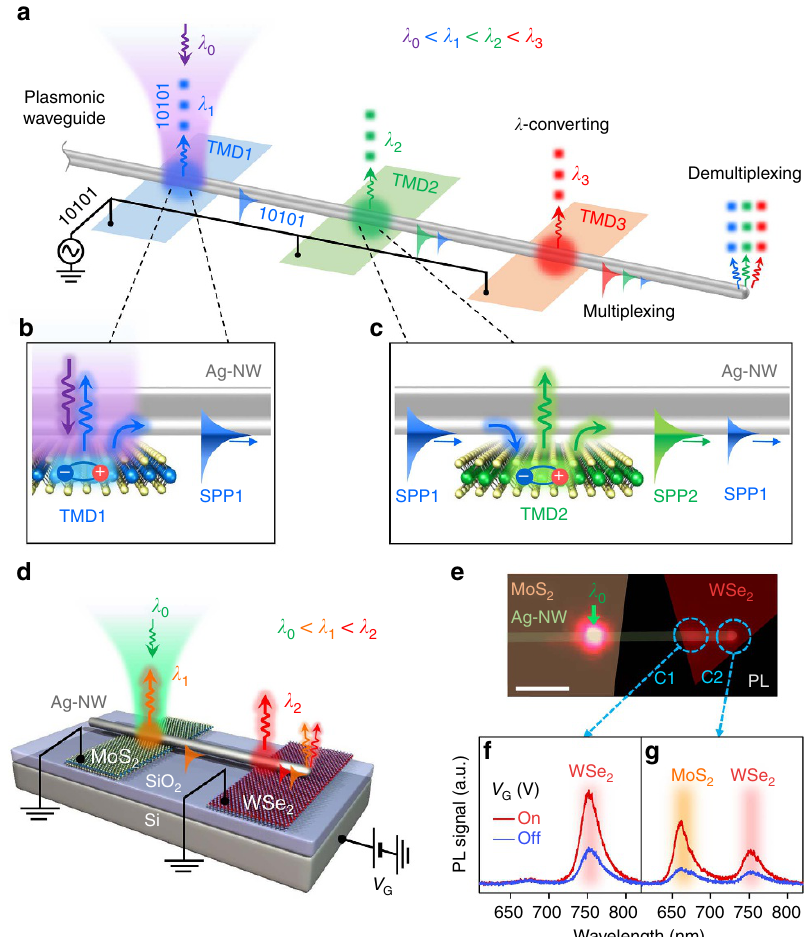
Figure 3 | Exciton multiplexer. ( a ) Laterally arrayed TMDs with different bandgaps bridged via an Ag-NW. The exciton flux of each TMD with the corresponding wavelength ( l ) is switched by electrical doping, ( b ) l 1 excited by the input light is coupled to SPP1 in the NW, ( c ) propagates along the NW and then excites l 2 by partially being absorbed in TMD2 that is coupled to SPP2 in the NW. SPP1 and SPP2 excite l 3 in TMD3 and generate SPP3. The three SPP modes deliver the multiplexed wavelengths with optical information generated by electrical modulation. The multiplexed wavelengths are further de-multiplexed by far field scattering at the NW end. ( d ) Schematic of the device consisting of MoS 2 and WSe 2 monolayers bridged by Ag-NW. Each exciton flux is modulated by V G . ( e ) PL image overlaid with the device structure. The green arrow is the l 0 position. C1 and C2 are the PL collection positions. Scale bar: 2 m m. The PL spectra measured at ( f ) C1 and ( g ) C2 positions for V G of (cid:2) 100 and